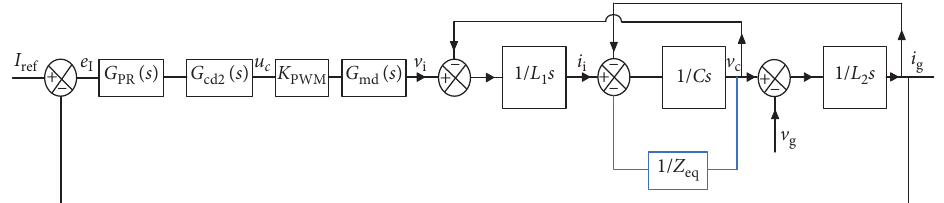
without the AD loop, with and without considering the delay when ω ol